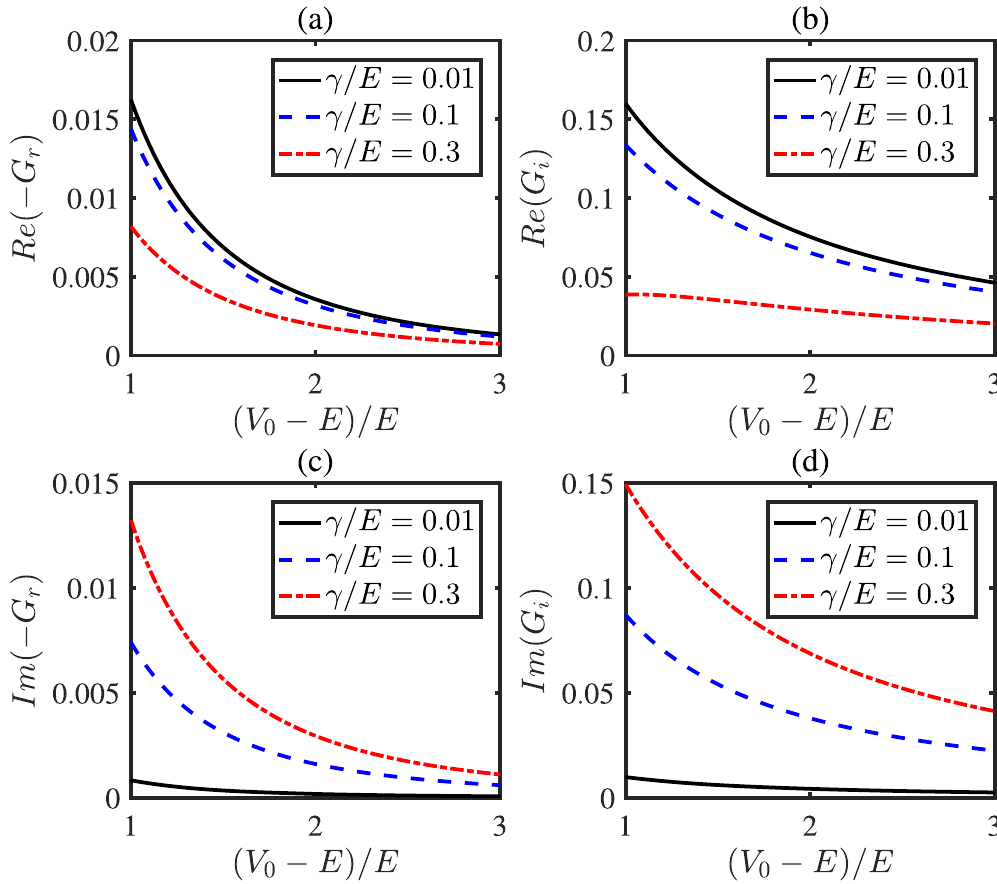
Figure 2. ( a ) and ( b ) show the real parts of G r and G i as a function of the insulating gap ( V 0 − E )/ E with different γ / E , while ( c ) and ( d ) are for the imaginary parts of G r and G i . The spin mixing conductance is plotted in units of e 2 / ħa 2 . The other parameters chosen in the figure are θ = 0.3 π , − gS / E = 0.2, and μ 0 / E =